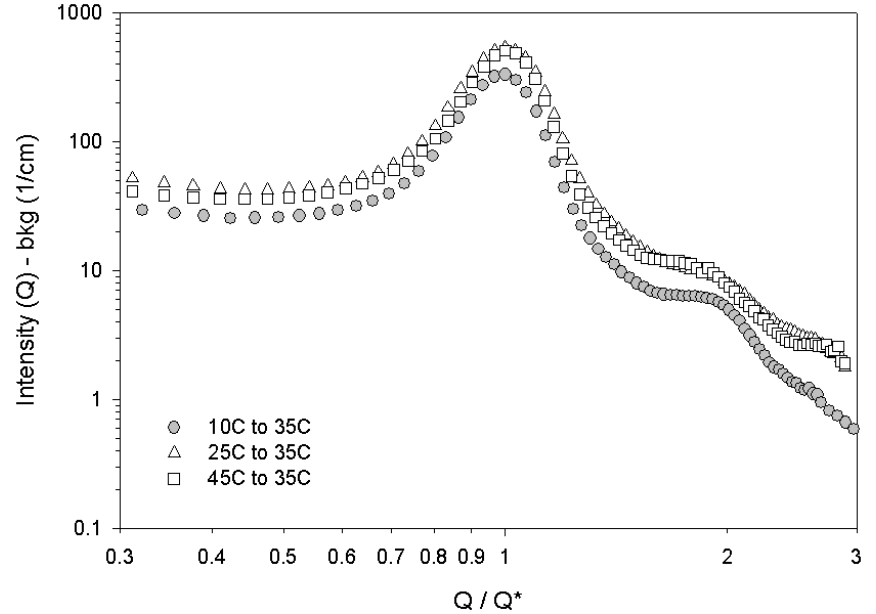
Figure 6. The SANS intensity versus Q/Q* is compared for 35 wt% block copolymer at 35 °C for three different thermal